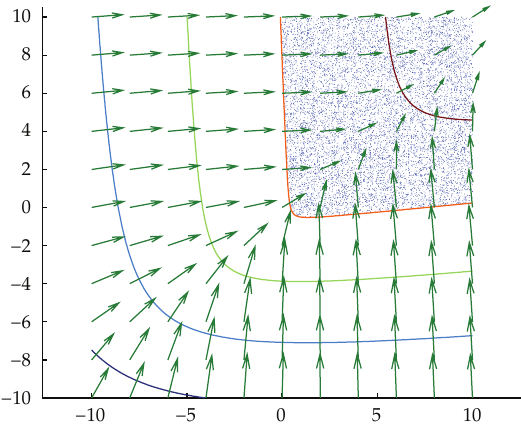
Figure 5: The gradient vector field of f (cid:2) x (cid:3) for cone (cid:2) 1 (cid:3) of Example 2.1.